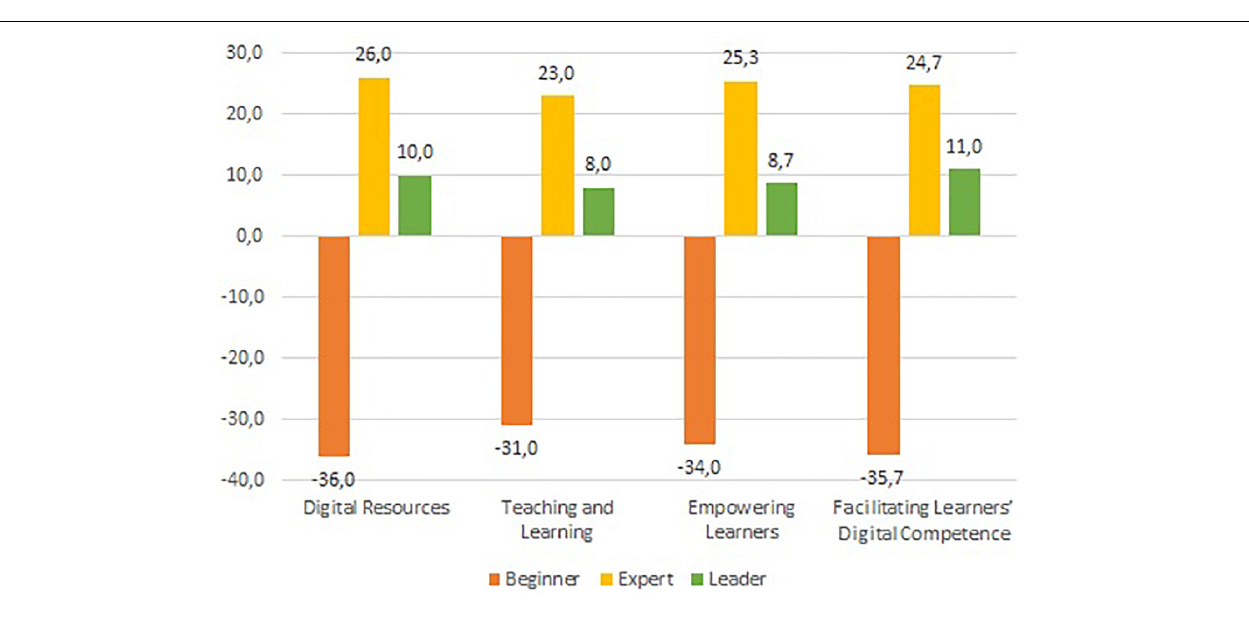
participants. In other areas, the growth of competences was not so conclusively